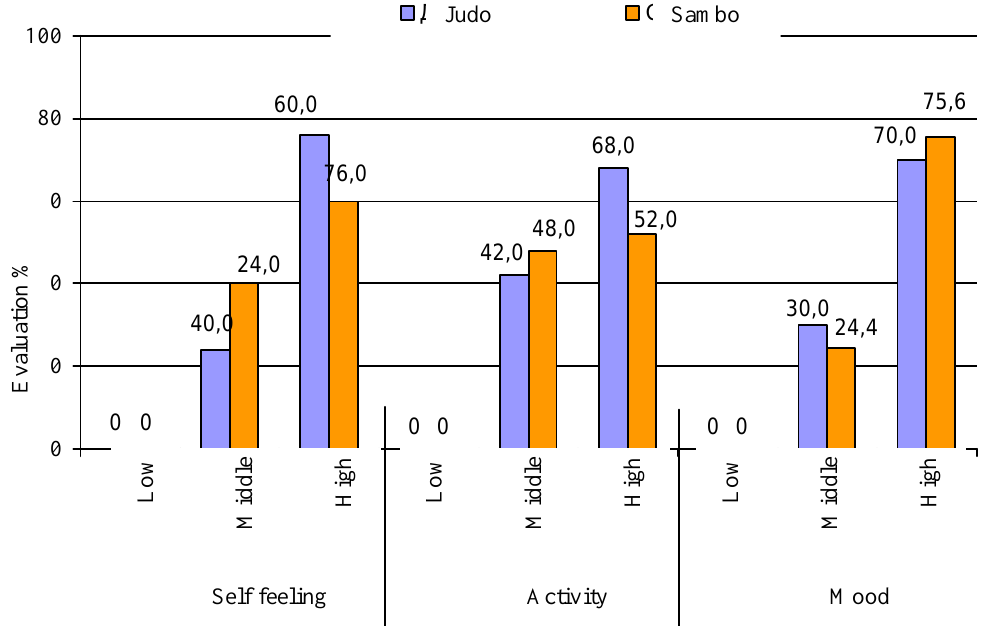
Fig 2. Evaluation of sportswomen’s state in the day of competition